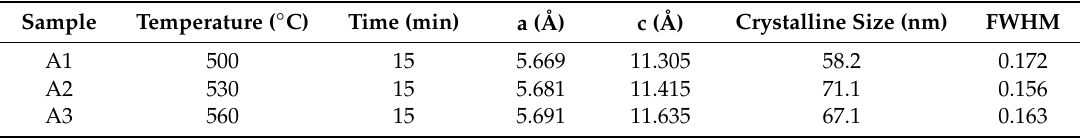
Table 1. The full width at half-maximum (FWHM), grain size, a-axis lattice constant (a), and c-axis lattice constant (c) for CMZTSSe films annealed at different temperatures.